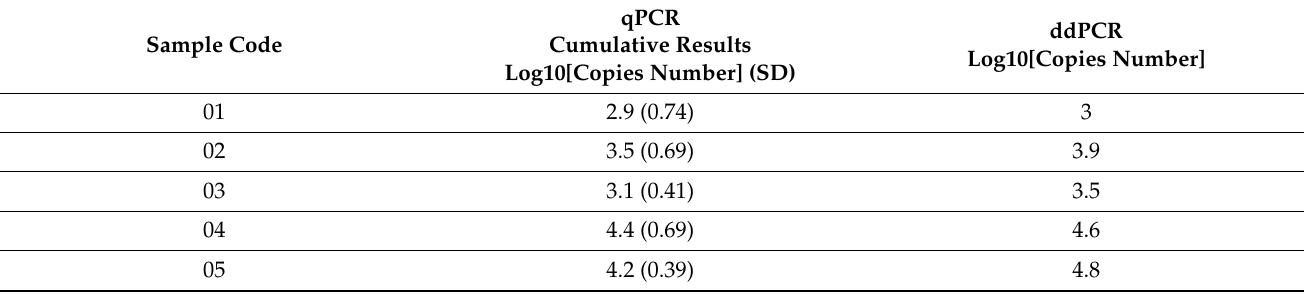
Table 2. Comparison of ddPCR with qPCR proficiency data from cumulative results from a total of 42 clinical laboratories in the United States and Europe. SD = Standard